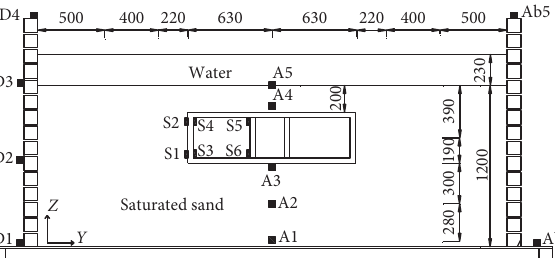
Transverse direction of the tunnel Longitudinal direction of the tunnel